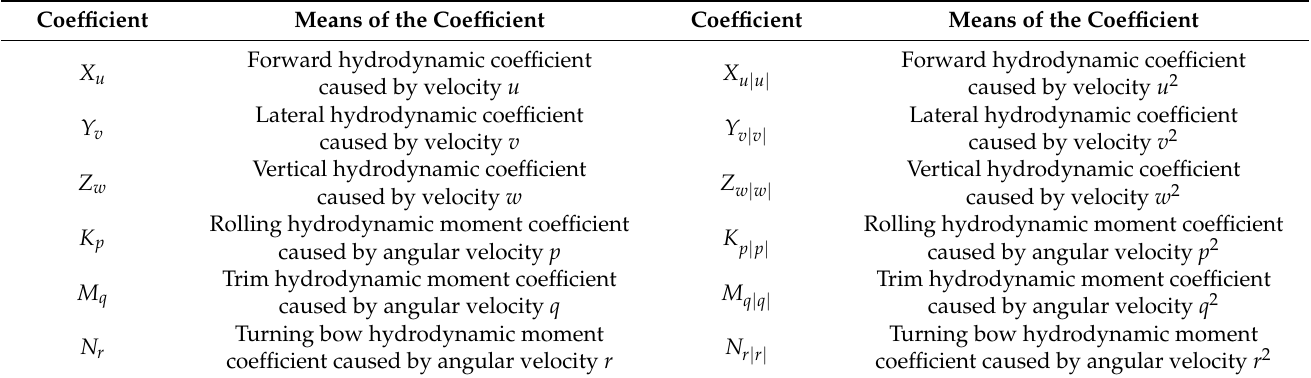
Table 1. All coefficients in Equations (4) and